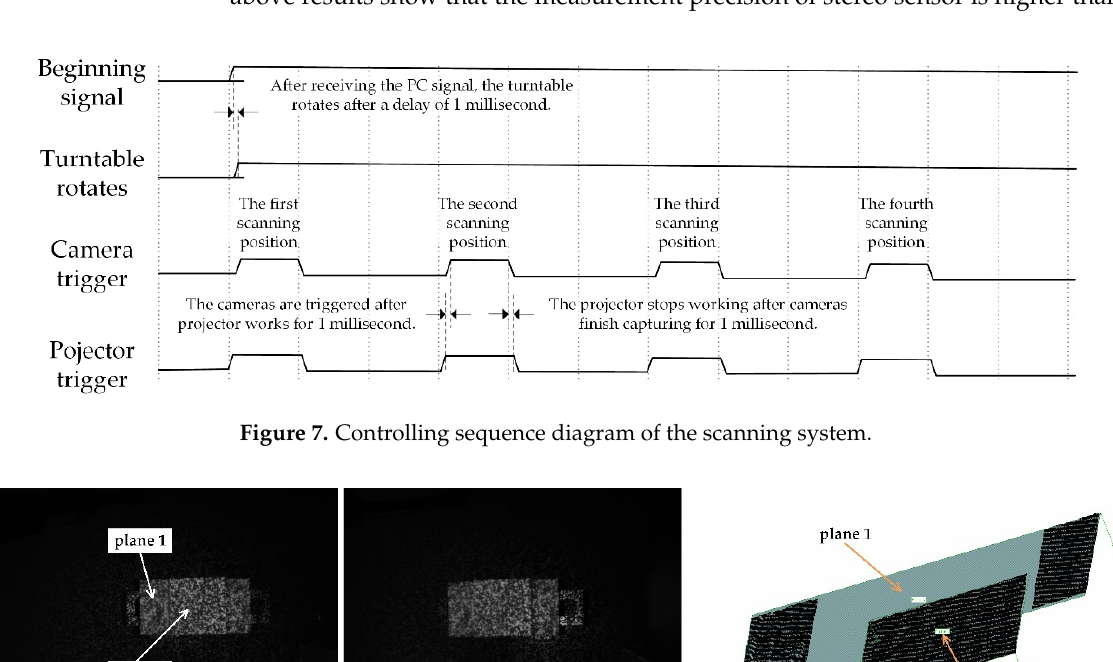
plane 2. The statistics of depth measurement error are listed in Table 1, the minimum error, Figure 6. Multi-sensor collaborative human body scanning system.